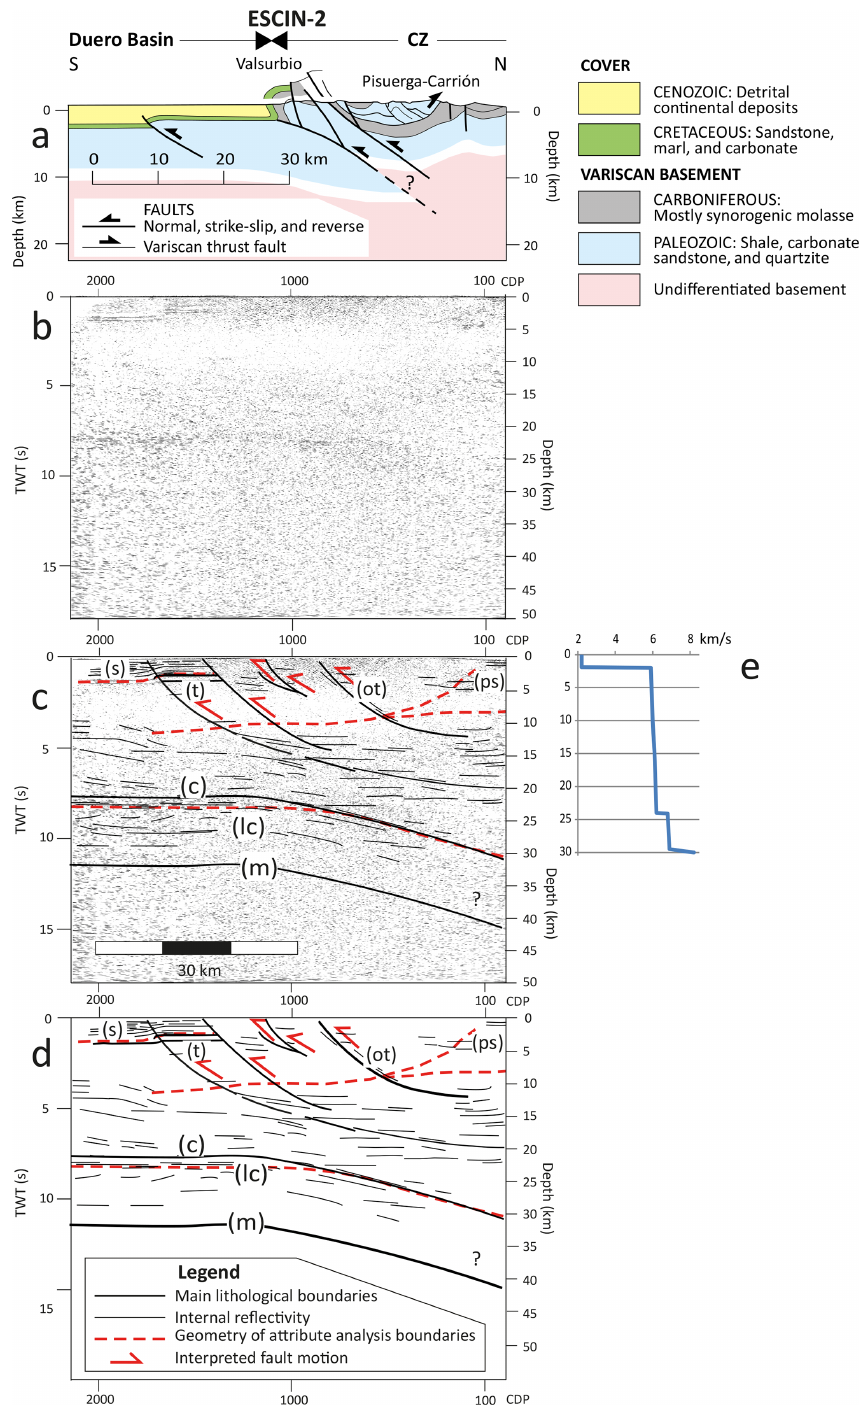
Figure 4. Cross section (a) modified from Gallastegui et al. (2016) and the depth-converted time-migrated section (v = 5600m/s) of the NI seismic profile ESCIN-2 (Fig. 1), without (b) and with (c) interpretation. A sketch of the most important features is presented in panel (d) . A 1D velocity profile as modeled from wide-angle data (Pulgar et al., 1996) appears in panel (e) . The abbreviations used in the figure are as follows: CDP is the common depth point, TWT is the two-way travel time, and CZ is the Cantabrian Zone. Some discontinuous reflections are traced on the basis of their geometry on the stack image (Pulgar et al., 1996). Red dashed lines represent the boundaries provided by chaos and variance attribute analyses. The nomenclature for reflections is as follows: (s) is sediments, (t) is thrusts, (ot) denotes outcropping thrusts, (ps) is Paleozoic sediments, (c) is top of the lower crust, (lc) is the lower crust, and (m) is the Moho. Depth conversion is based on migration